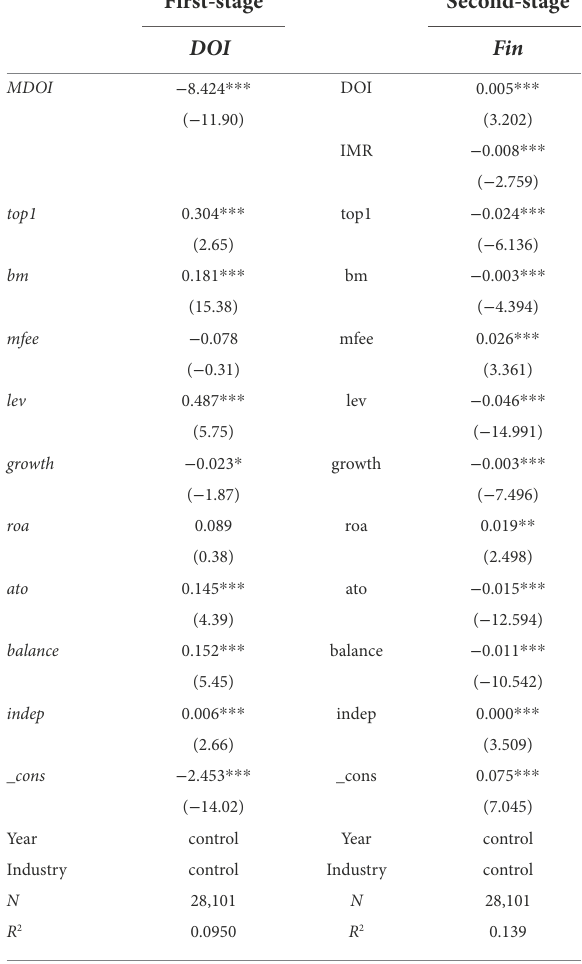
TABLE 7 Results of the Heckman two-stage